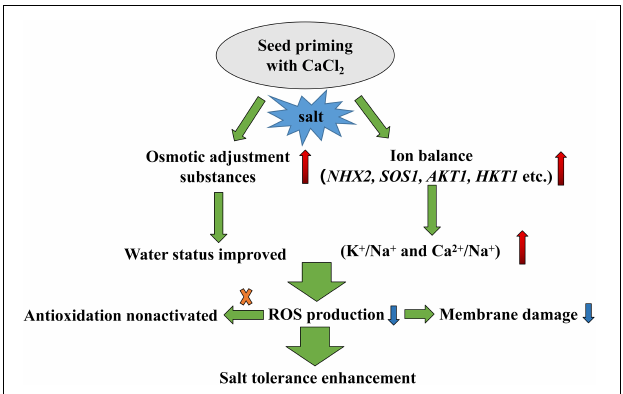
FIGURE 10 | A flowchart of CaCl 2 priming enhancing salt tolerance during sorghum germination. The red arrows indicate increase and blue arrows indicate